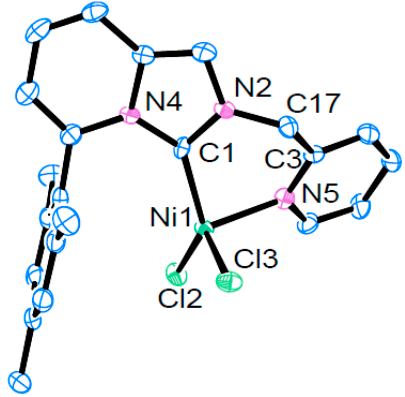
Figure 5. Molecular structures of 12 . Thermal ellipsoids are set at 50% probability. Hydrogen atoms have been omitted for clarity. Selected bond lengths [Å] and angles [ ◦ ]: Ni(1)–C(1) 1.991(9), Ni(1)–N(5) 2.047(8), Ni(1)–Cl(2) 2.224(2), Ni(1)–Cl(3) 2.273(3); C(1)–Ni(1)–N(5) 92.0(3). Selected torsion angles [ ◦ ]: C(1)–N(2)–C(17)–C(3) 57(1), N(2)–C(17)–C(3)–N(5) -51(1), C(17)–C(3)–N(5)–Ni(1)